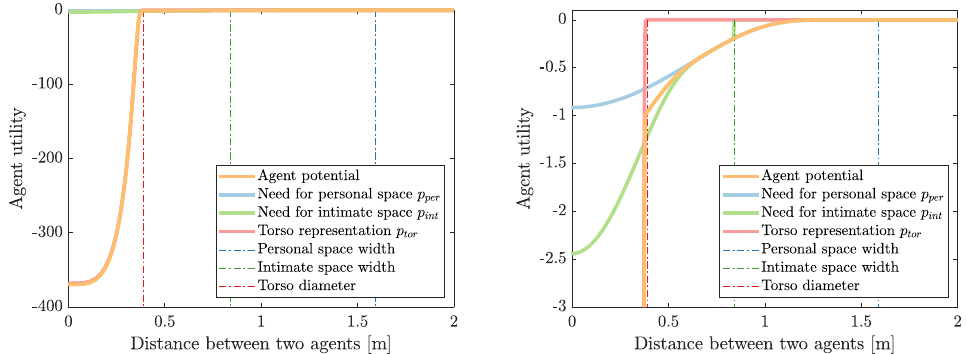
Figure A1. Soft-shell agent utility U p , l , i models the personal and intimate space of agents.